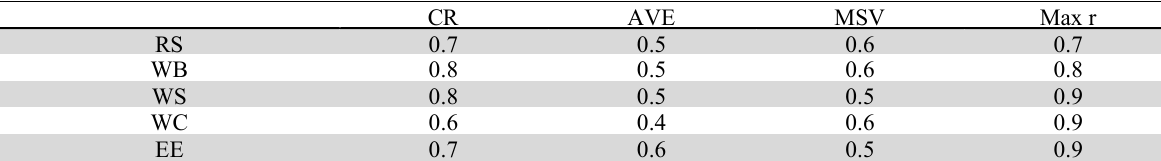
Convergent Test